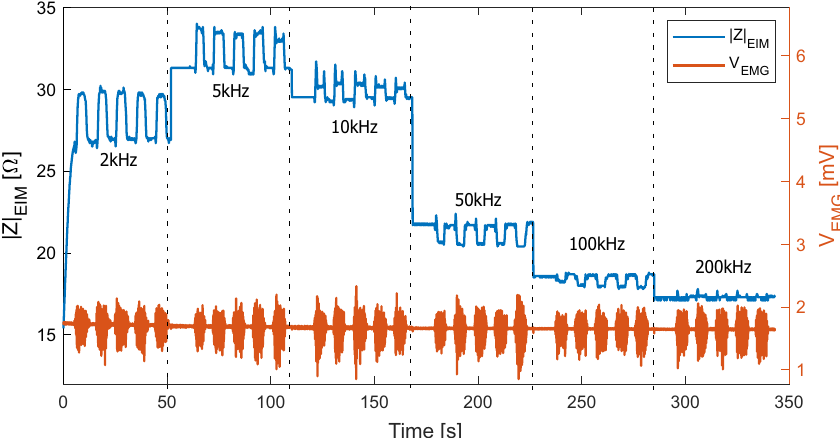
Figure 14. EIM of volunteer 1 during the contraction test with 7 kg. The EMG amplitude is higher during